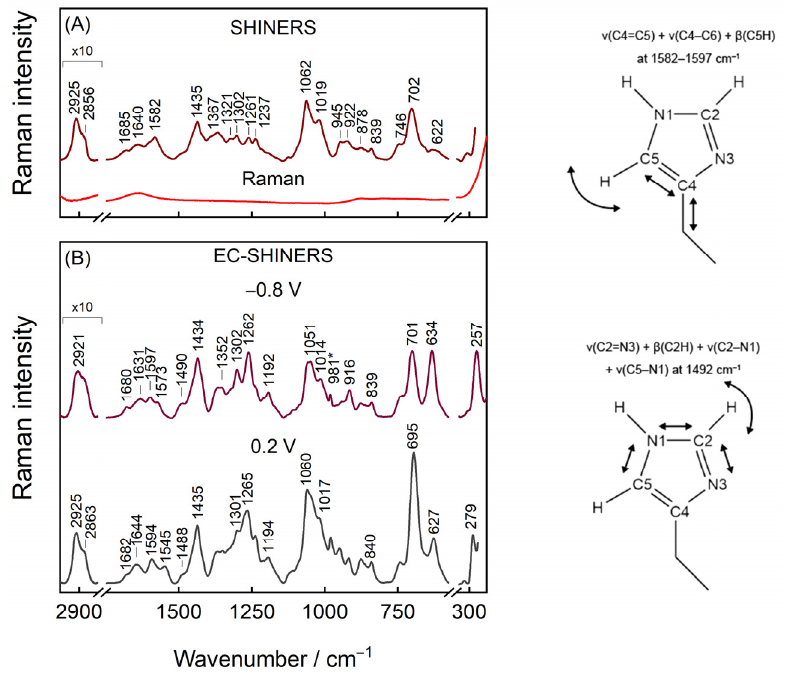
Figure 6. ( A ) SHINERS and Raman spectra of IMHA SAM on a smooth Au electrode in H 2 O. ( B ) EC-SHINERS spectra recorded at − 0.8 and 0.2 V potentials in phosphate buffer solution (PBS; pH 7.0, with 0.1 M Na 2 SO 4 ). Asterisk (*) at 981 cm − 1 marks SO 42– vibrational mode from the solution. Cartoon depicts the selected imidazole ring motions.